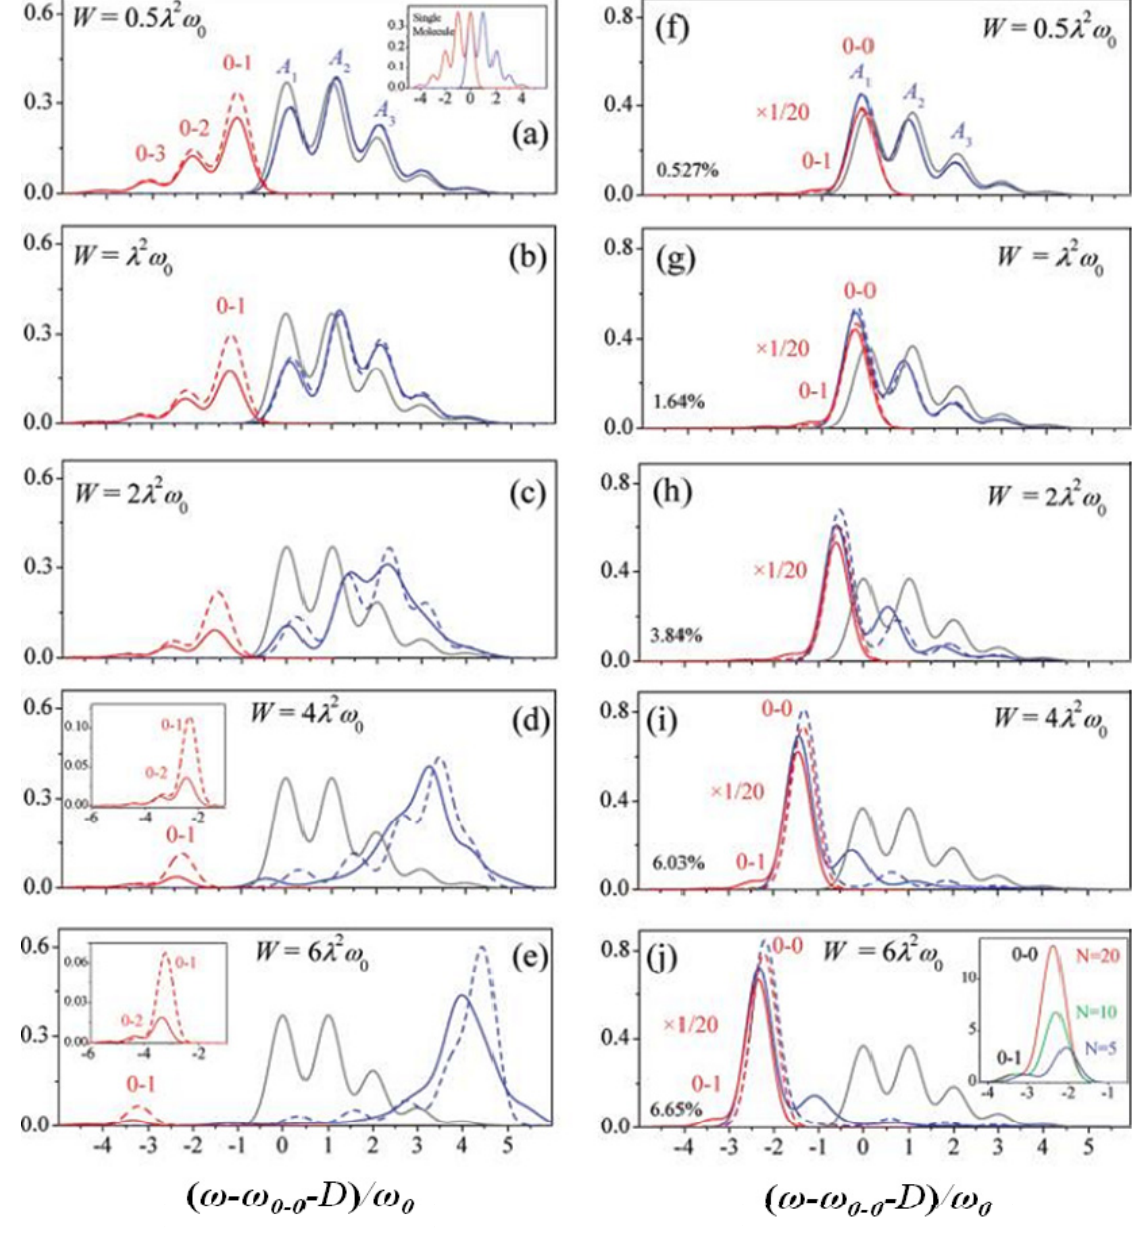
Figure 2. Calculated absorption ( blue ) and emission ( red ) spectra for linear H- and J-aggregates containing N = 20 molecules with nearest-neighbor-only coupling. In all calculations the value of ω = 0.17 eV (1400 cm − 1 ) were taken. The exciton bandwidth, 0 W = 4| J |, increases from top to bottom [( a – e ) for H-aggregate and ( f – j ) for J-aggregate]. 0 Solid spectra are evaluated using one- and two-particle states, while dashed spectra use only one-particle states. Inset in panel ( a ) shows the isolated-molecule spectra. Gray absorption spectrum appearing in all panels pertains to the isolated molecule ( W = 0). Insets in panels ( d ) and ( e ) are enlarged emission spectra. Inset in panel ( j ) shows unscaled emission spectrum for different values of N (Reprinted with permission from [32]. Copyright 2010 American Chemical